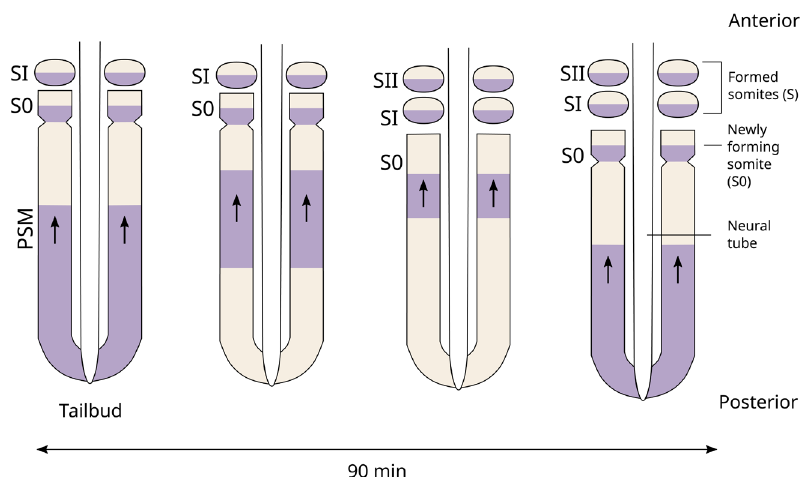
Figure 2. Time to space translation. Kinematic waves of gene expression sweep the A-P axis, arresting anteriorly, followed by somite